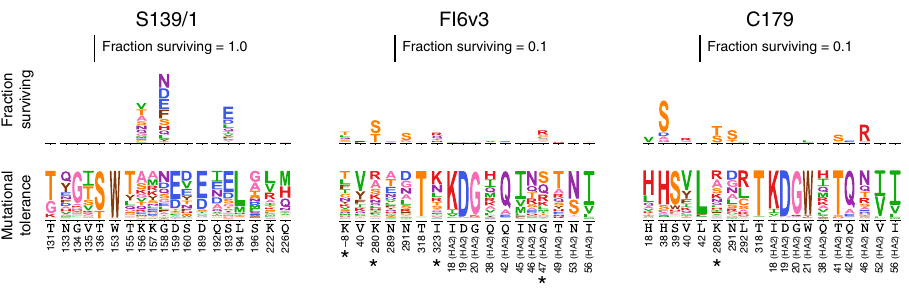
Fig. 7 Mutational tolerance of HA sites in the antibody-binding footprints. These plots show all HA sites within 4 Å of the antibody in the crystal structure, plus any additional sites (marked with a *) where we identi fi ed antigenic mutations. The logo plots at bottom show the preference of each HA site for each amino acid under selection for viral replication as measured by Doud and Bloom 54 . For instance, site 153 only tolerates tryptophan, so W occupies the entire height of the preference logo stack. In contrast, site 156 tolerates many amino acids, all of which contribute to the height of the preference logo stack. Above the preference logo stacks are logo plots showing the excess fraction surviving antibody treatment as measured in the current study. Note that scale for these antigenic effects is 10× smaller for FI6v3 and C179 than for